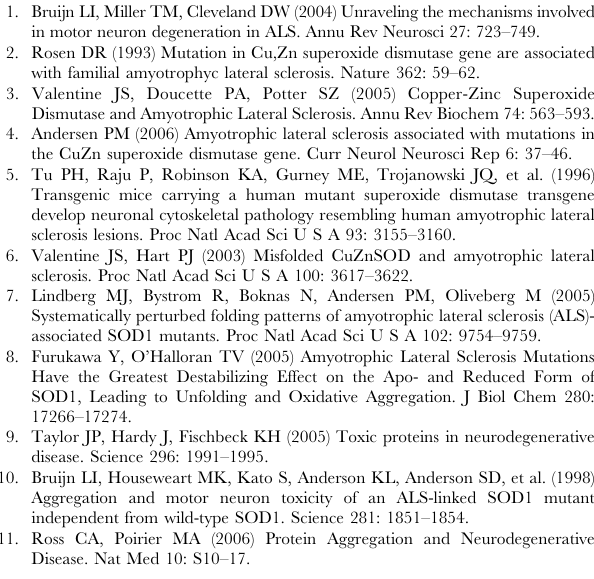
Figure S1 Formation of ThT-binding structures when apo SOD1 mutants and WT are incubated at 37 u C. Fluorescence due to ThT binding to SOD1 mutants (presented as arbitrary units, A.U.) for apo T54R SOD1 ( N apo D90A SOD1 (N˜ ), apo I113T SOD1 ( ¤ ) and apo WT SOD1 (O), during the incubation of the samples at 37 u C. Error bars are standard deviations values obtained from two/three repeats of the experiments.